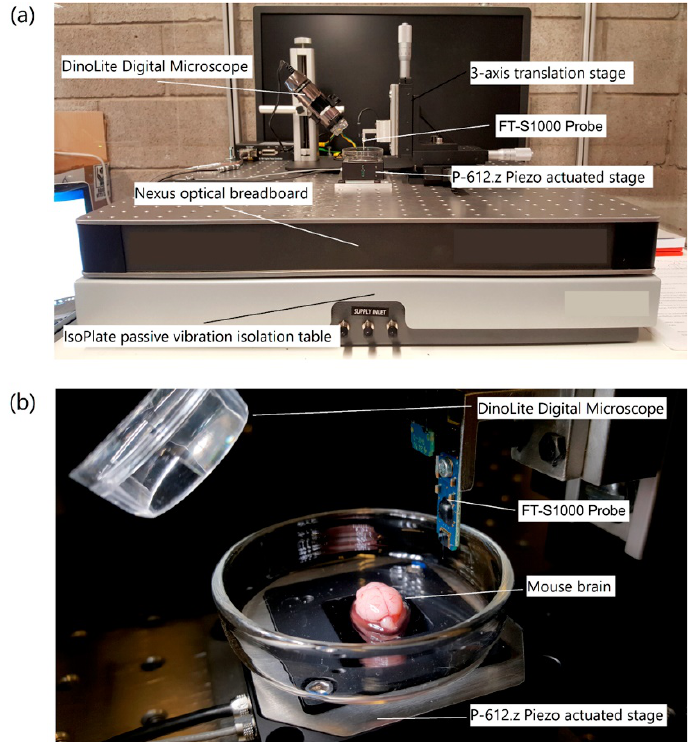
Figure 9. ( a ) Major components of the custom built micro-indentation experimental apparatus, and ( b ) a close-up of the force sensing probe and mouse brain specimen prior to indentation. Reproduced with permission from [153].